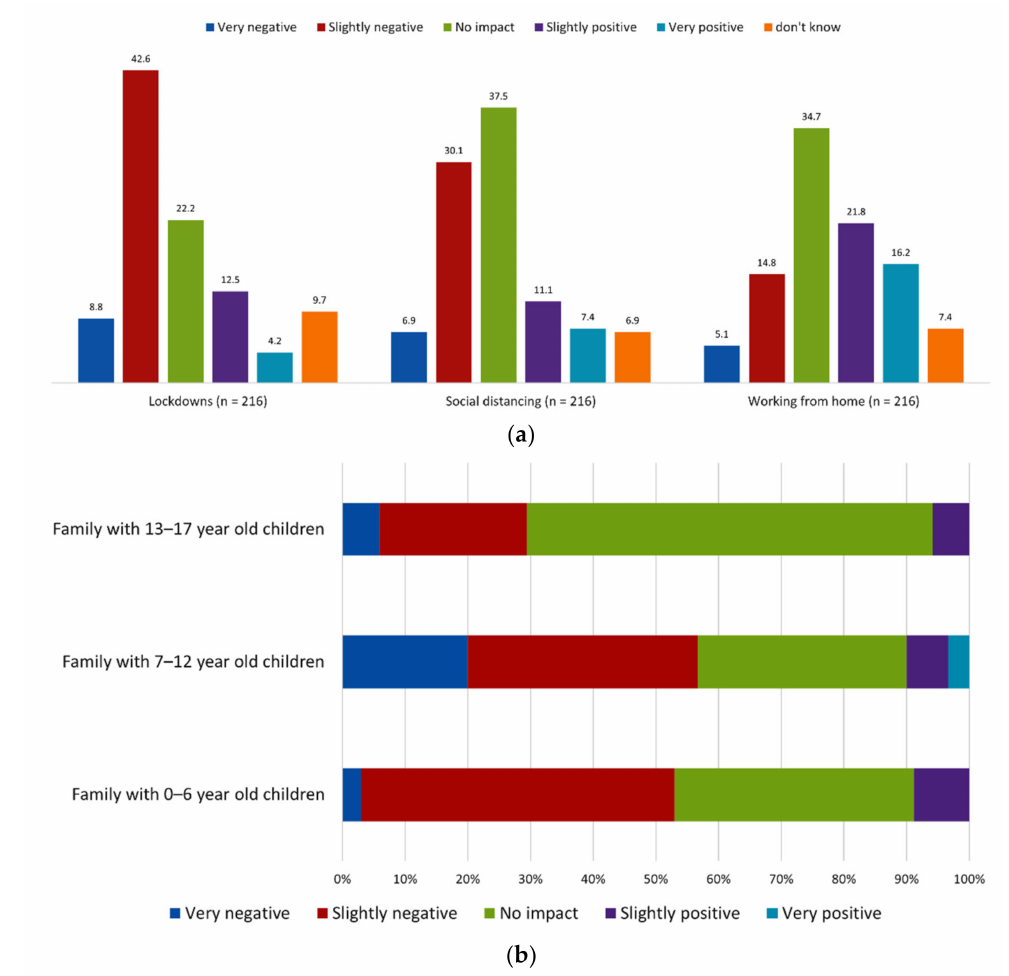
Figure 5. Impact on respondent’s daily routings of COVID-19 restrictions: ( a ) Lockdowns ( n = 216), Social distancing ( n = 216), and working from home ( n = 216) and ( b ) combining full-time remote (home) working with home schooling of children ( n =